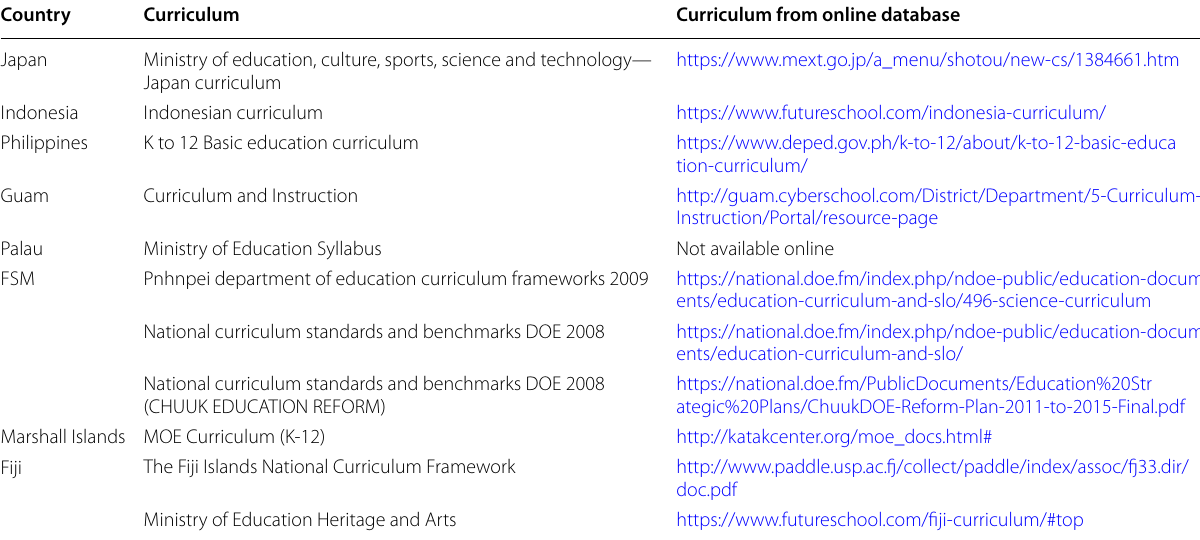
This table shows the online sources of curricula of each country. The online source was not available only in